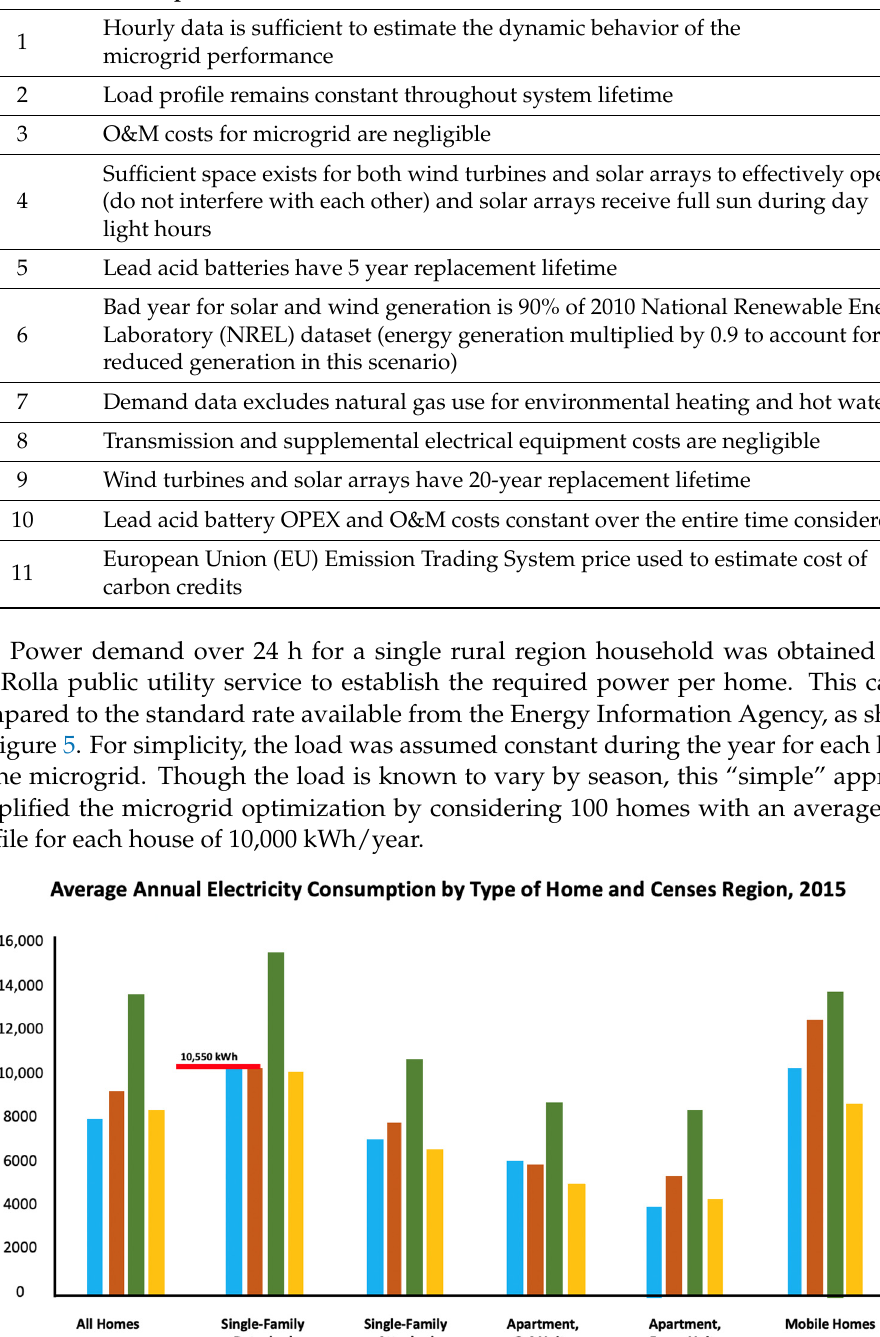
Table 4. Assumptions used in microgrid design analysis.